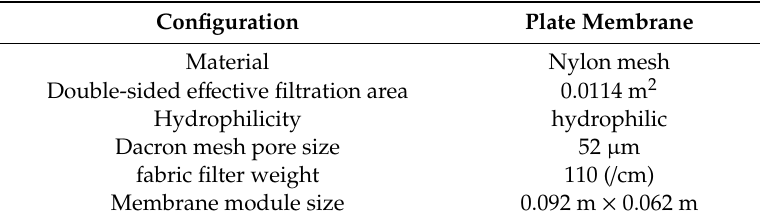
Table 1. General information about the DMBR filter